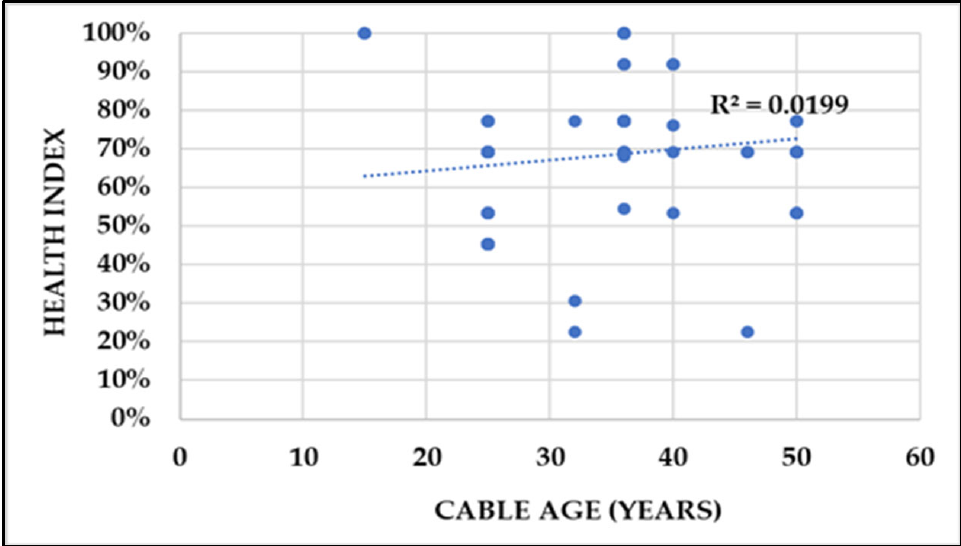
Figure 7. Relationship between HI and cable age.